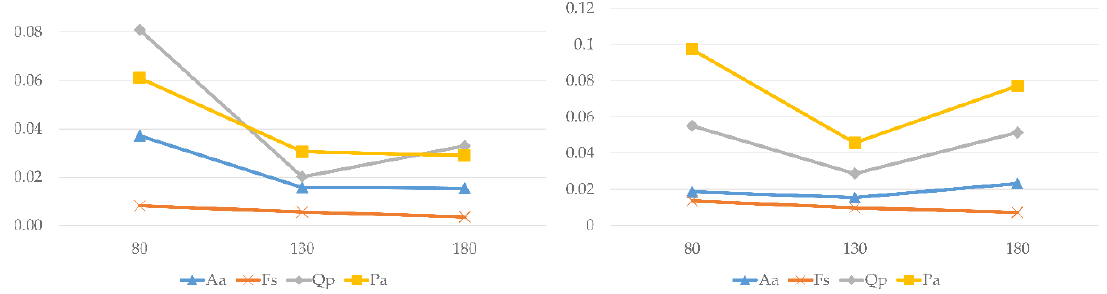
Figure 6. Variances of measured reference data separated by tree species. Perimeter is shown on the left and diameter on the right (cm) (Aa: Abies alba Mill.; Fs: Fagus sylvatica L.; Qp: Quercus petraea (Matt.) Liebl.; Pa: Picea abies (L.) H. Karst.).